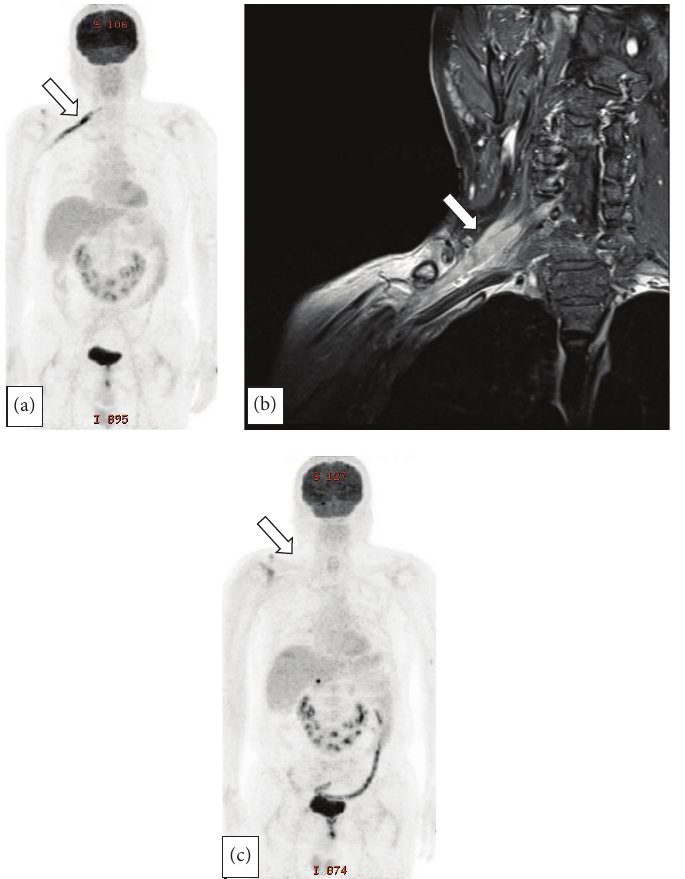
Figure 1: (a) PET-CT. Strong linear FDG uptake along the right brachial plexus was found, which had not been seen on PET-CT performed 2 months ago (white arrow). (b) Cervical spine MRI with contrast enhancement. The trunk of the right brachial plexus on the level of C5 and C6 were thickened with heterogeneous enhancement, suggesting lymphoma infiltration. (c) Follow-up PET-CT. Right brachial plexus invasion was improved after chemoradiotherapy, but new lesions were seen in right temporal base, right sciatic nerve, and right adrenal